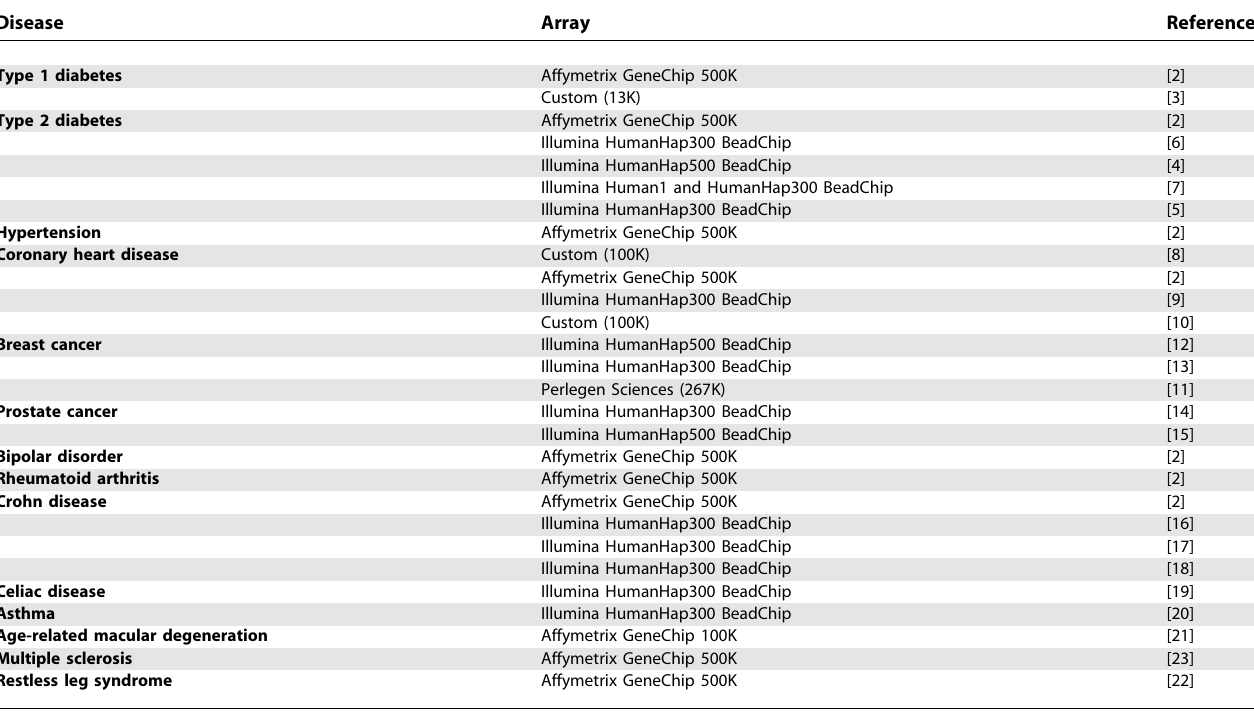
Table 1. Associations Identified in GWASs for Common Disorders Using Genotyping Arrays Disease